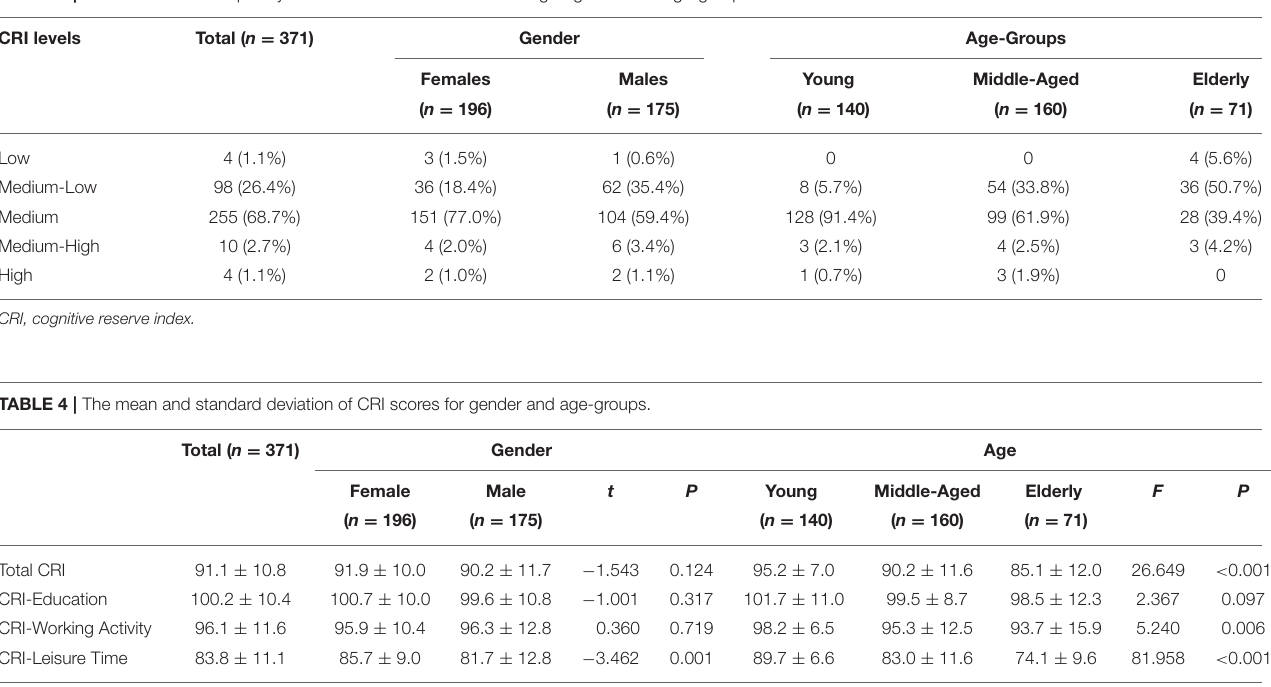
TABLE 3 | The number and frequency distribution of CRI levels according to gender and age-groups. CRI levels